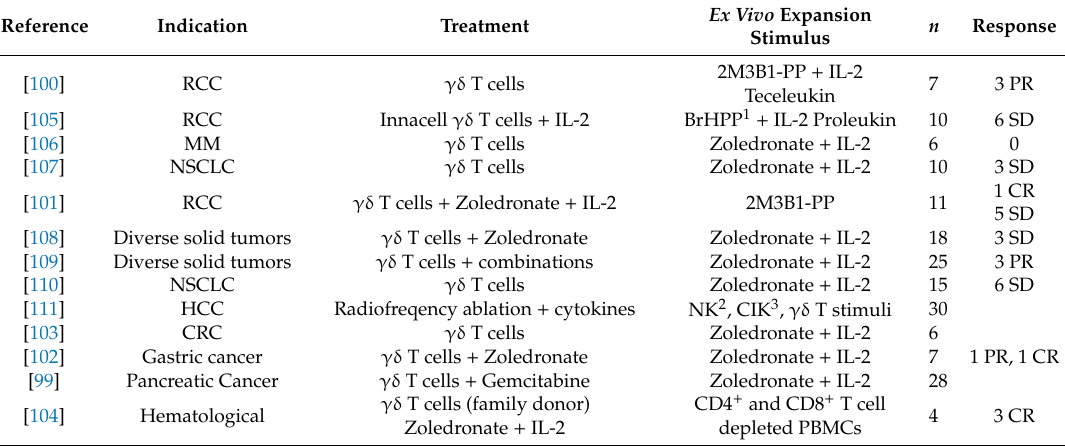
Table 1. Completed Phase I clinical trials with adoptive transfer of ex vivo expanded, autologous cancer. HCC: Hepatocellular Carcinoma. CRC: Colorectal Carcinoma. PR: Partial Response. SD: Stable Disease. CR: Complete Response. 1 Bromohydrin Pyrophosphate (BrHPP). 2 Natural Killer (NK)